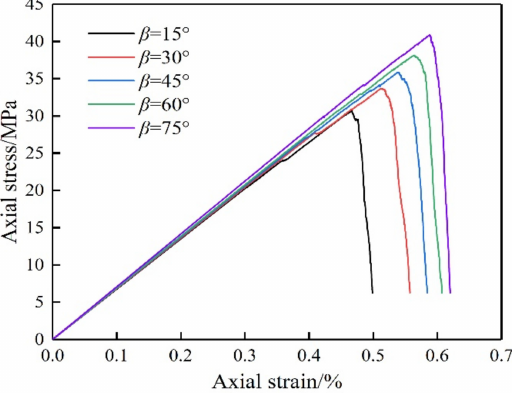
Figure 3. Axial stress–strain curves of sample models with different flaw inclination